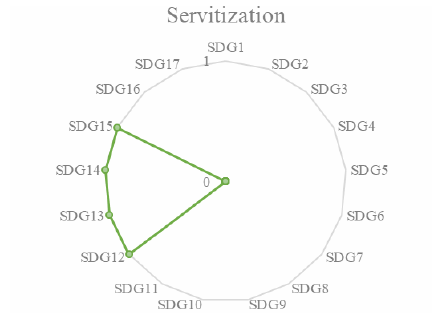
Figure 5. Fashion industry cluster of application effect on SDGs